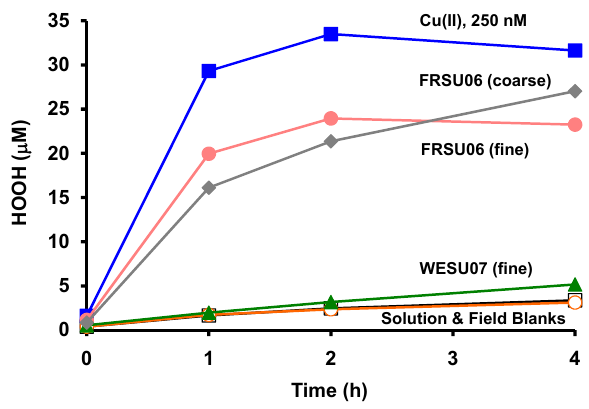
Fig. 1. Examples of HOOH generation from fine and coarse San Joaquin Valley particle samples extracted in a surrogate lung fluid containing ascorbate: FRSU06 = Fresno summer 2006, WESU07 = Westside summer 2007. 250 nM Cu(II) was used as the positive control. The solution and field blanks generated very similar, low background HOOH